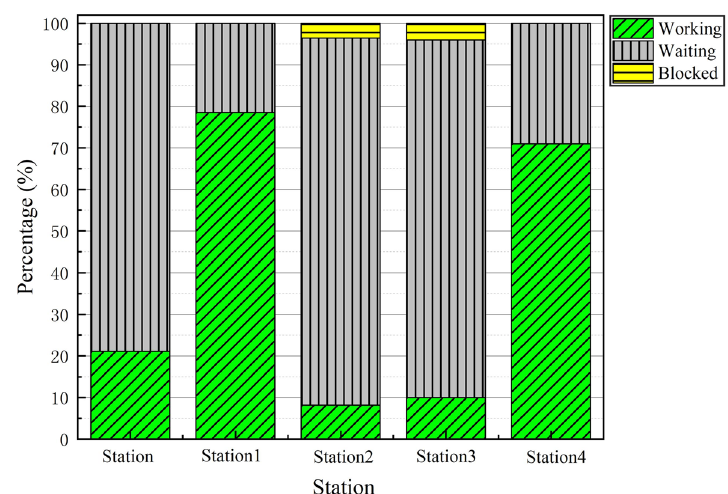
Fig. 10 Work at workstation after optimization